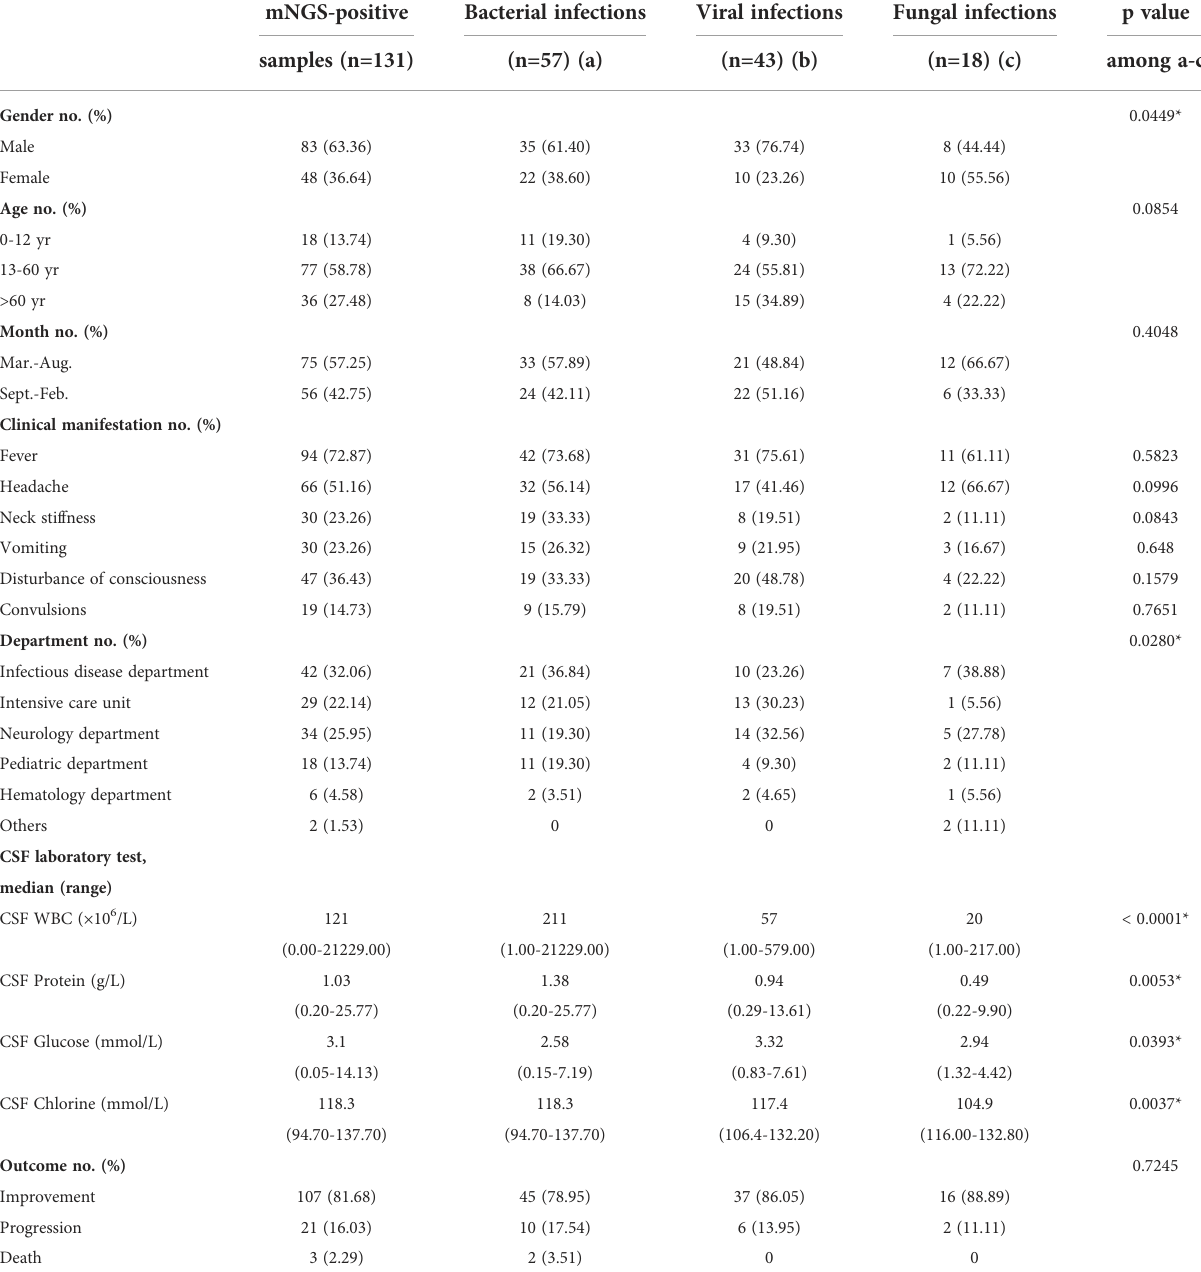
TABLE 1 Clinial characteristics and CSF laboratory examinations of enrolled cases.